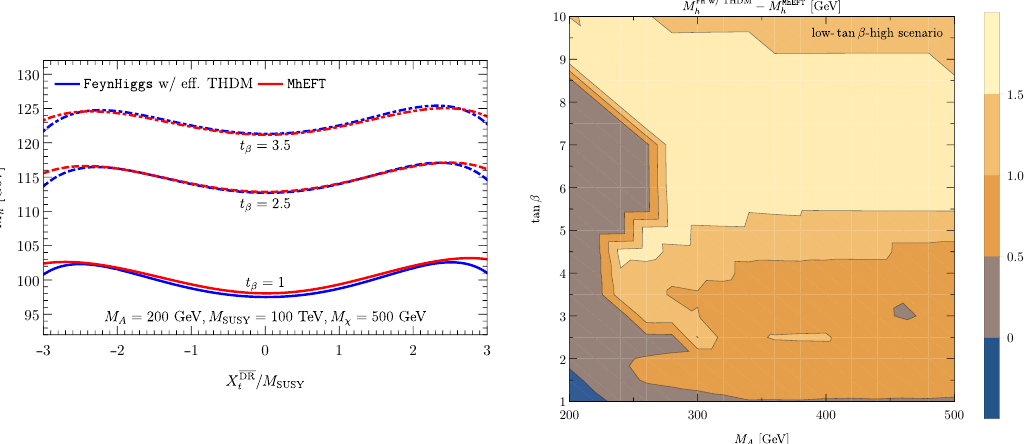
Figure 12 . Left: M h as a function of X t for tan (cid:12) = 1 (solid), tan (cid:12) = 2 : 5 (dashed), and tan (cid:12) = 3 : 5 (dotdashed). M A = 200 GeV is chosen. The results of FeynHiggs with e(cid:11)ective THDM (blue) and MhEFT (red) are compared. Right: M h in the \low-tan (cid:12) -high" scenario. The di(cid:11)erence between FeynHiggs with e(cid:11)ective THDM and MhEFT is